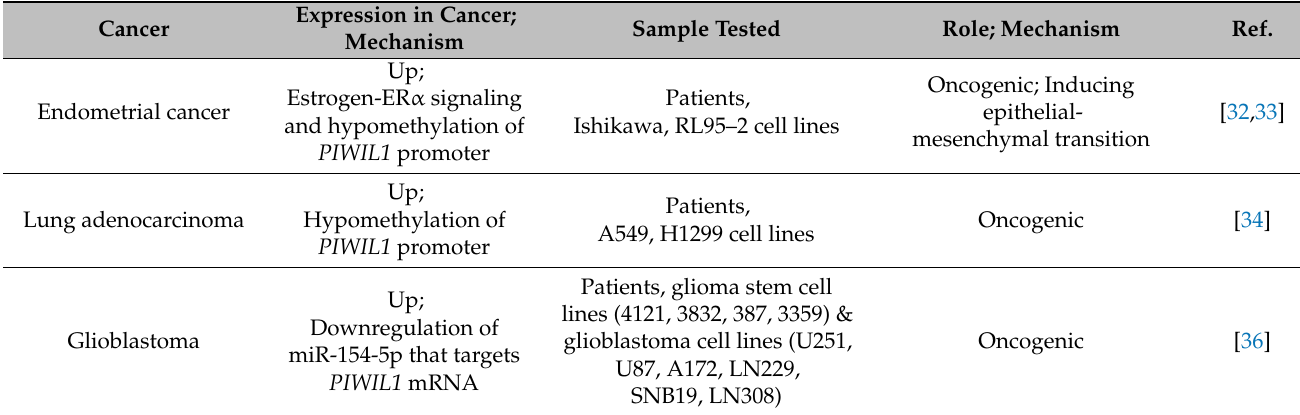
Table A1. Expression and role of PIWIL1 in